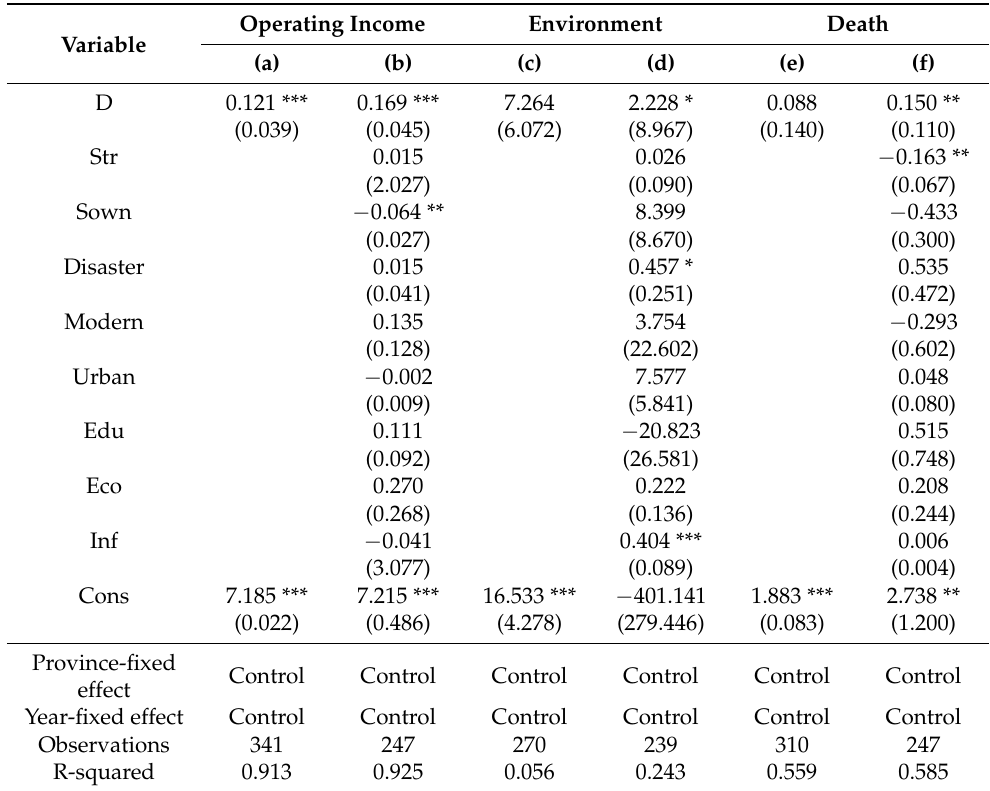
Table 6. Robustness